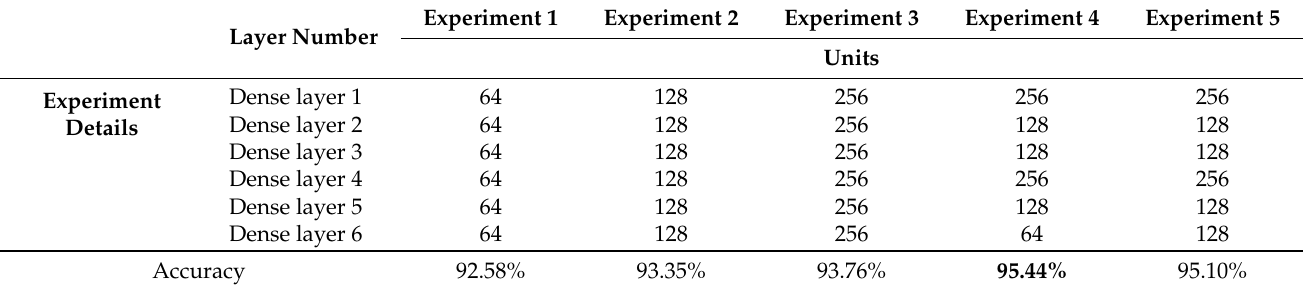
Table 7. Accuracy (in %) comparison of proposed models with different numbers of units of deep-neural-network layers.